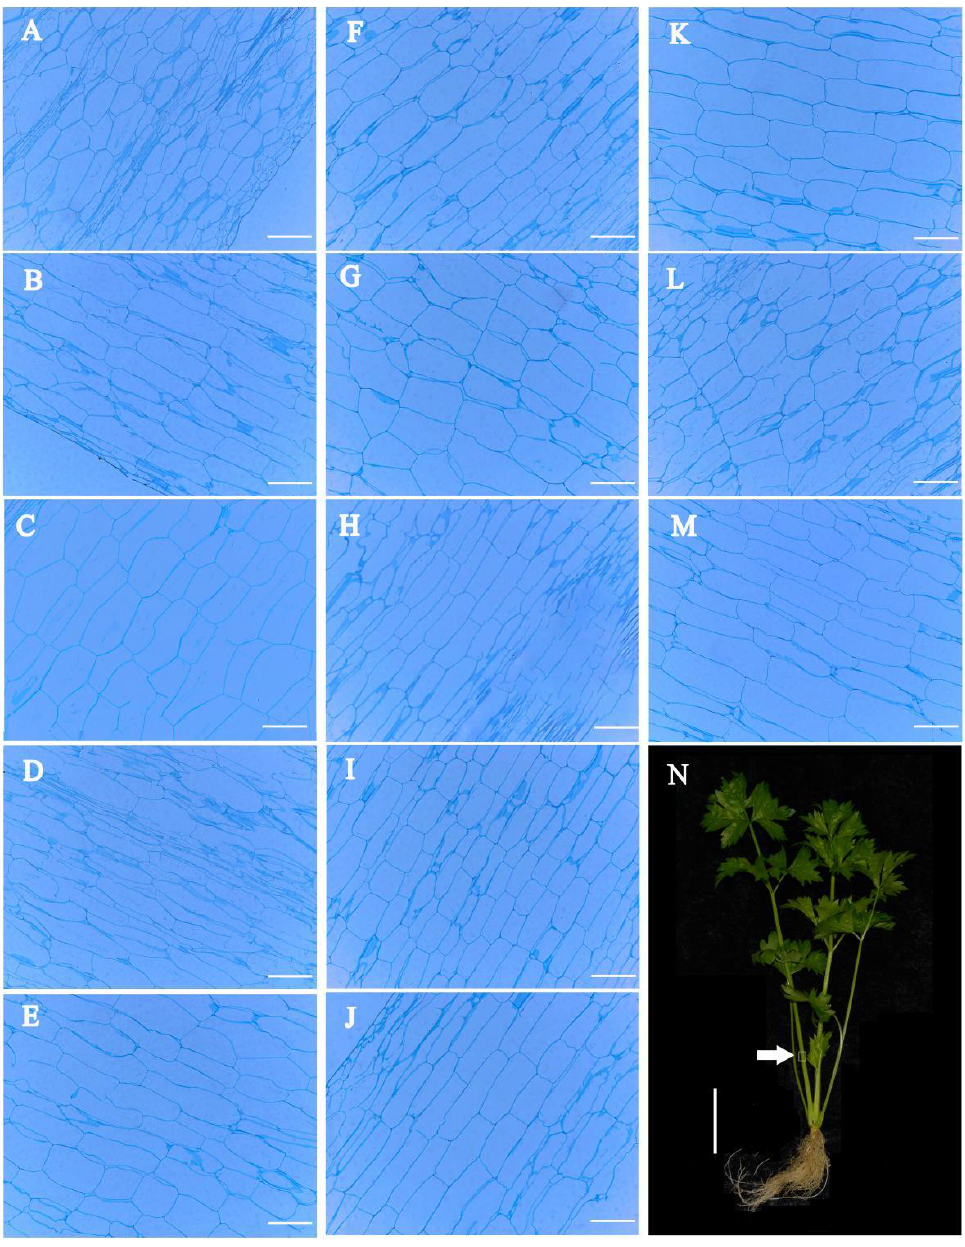
Figure 6. Effects of 24-EBL/PCZ/DCB treatments on the anatomical structure of celery petioles. ( A – E ) The anatomical structure of celery petioles treated with 0, 8.32 × 10 −7 , 1.24 × 10 −6 , 1.66 × 10 −6 and 2.08 × 10 −6 mol/L 24-EBL, respectively. ( F – J ) The anatomical structure of celery petioles treated with 0, 2.32 × 10 −5 , 3.49 × 10 −5 , 4.65 × 10 −5 and 5.81 × 10 −5 mol/L DCB treatments, respectively. ( K – M ) The anatomical structure of celery petioles in the control, PCZ + 1.24 × 10 −6 mol/L 24-EBL and 1.24 × 10 −6 mol/L 24-EBL treatment groups, respectively. ( N ) The petiole part for slicing. Scale bars in A – M = 100 μm, scale bar in N = 5 cm.